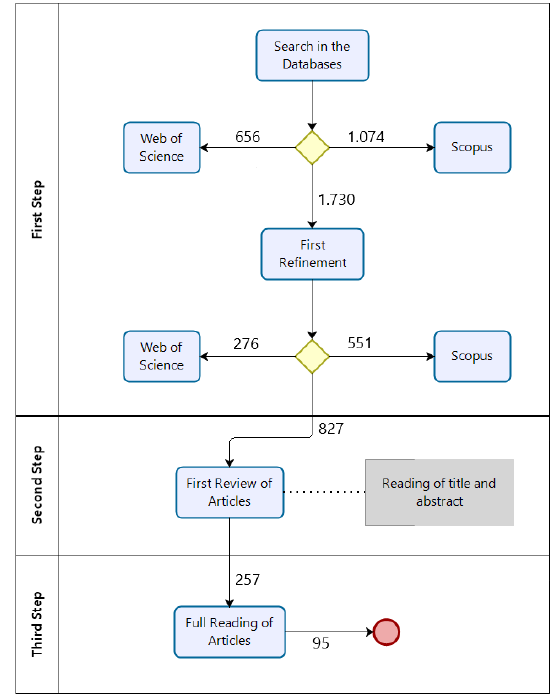
Figure 2. Search protocol fluxogram.